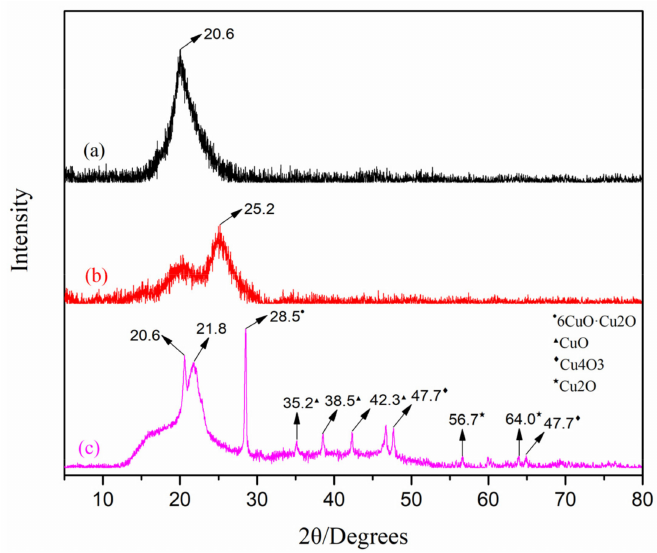
Figure 3. The XRD patterns of the CMC-Na (a), PANI (b), and Cu II/I @CMC-PANI film